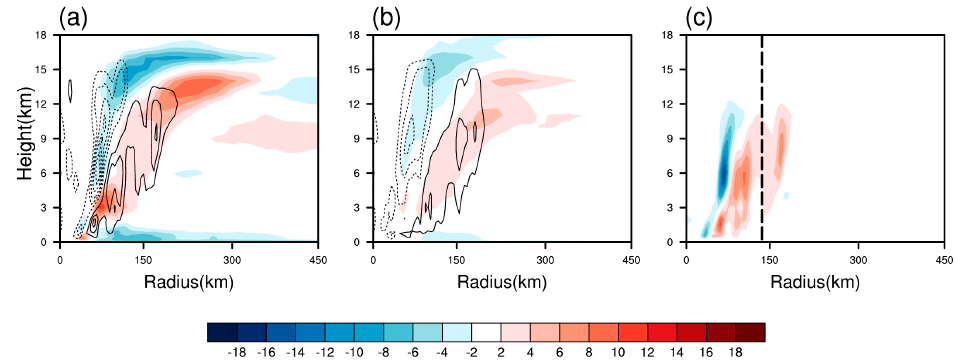
Figure 8. Height-radial cross-sections of the change of azimuthal-mean radial wind (shaded; m s − 1 ) and vertical velocity (contour; m s − 1 ) from hour 24 to hour 48 (i.e., hour 48 minus hour 24) derived from ( a ) the WRF simulation and ( b ) the SE equation diagnoses and ( c ) the change of the diabatic heating field (10 − 3 K s − 1 ) derived from the WRF model from hour 48 to hour 72.